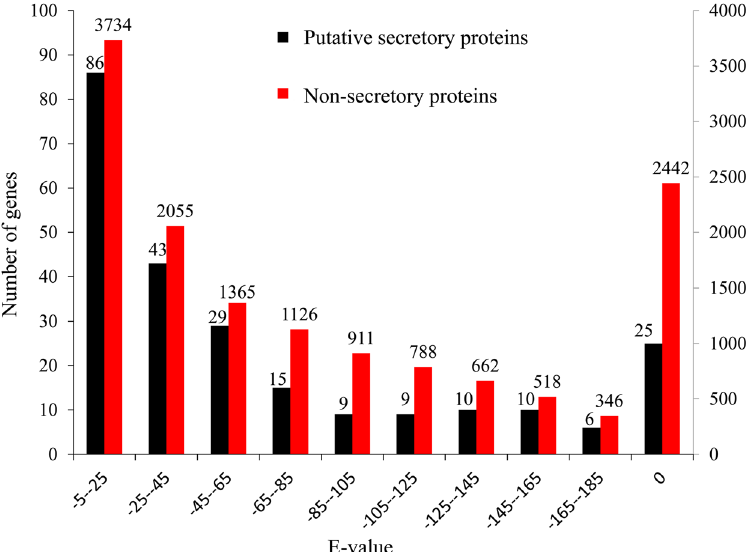
Figure 6. Sequence similarities of secreted proteins and non-secreted proteins between two venom